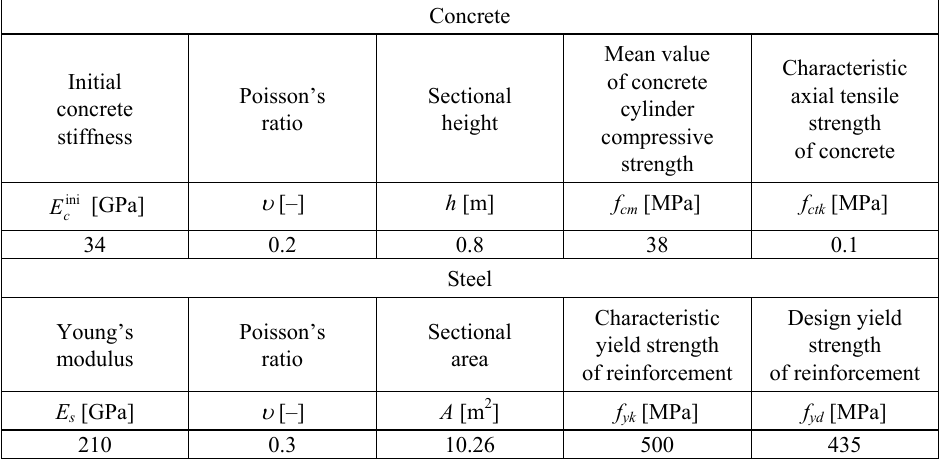
Table 1. Characteristics used in FE simulation for the non-linear model of retaining wall